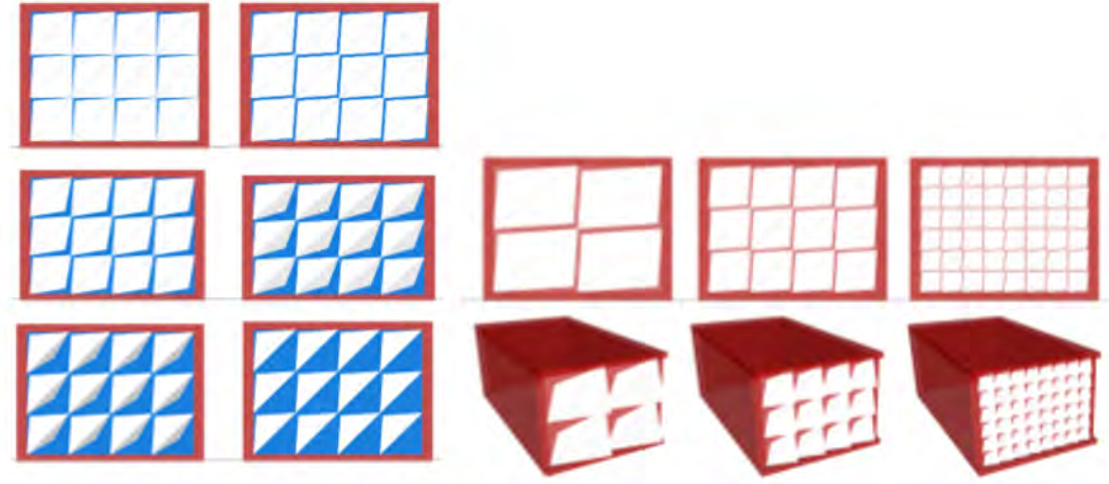
Figure 4. Different scale, composition and mechanism for a kinetic fac¸ade for optimizing daylight performance (source: Elghazi & Mahmoud, 2016)